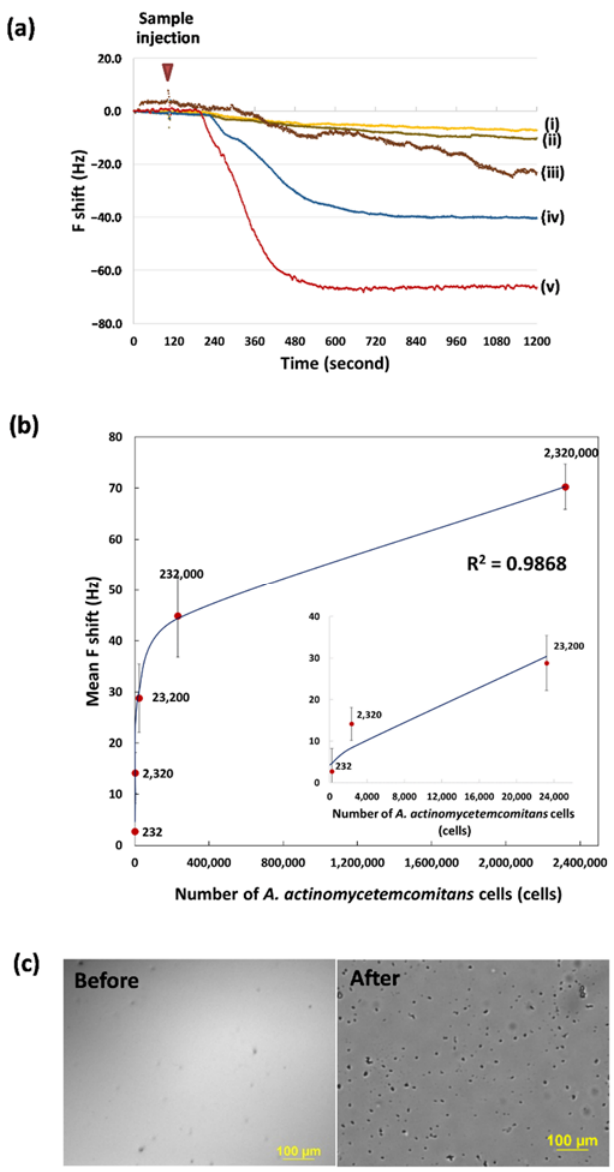
Figure 6. Label-free periodontal bacteria detection using QCM measurements. ( a ) The representa- tive sensorgram showing the sensor response at different A. actinomycetemcomitans concentrations: 200 µL A. actinomycetemcomitans suspension having: (i) 1.16 × 10 3 ; (ii) 1.16 × 10 4 ; (iii) 1.16 × 10 5 ; (iv) 1.16 × 10 6 and (v) 1.16 × 10 7 cells/mL. ( b ) The calibration curve of the QCM immunoassay for A.